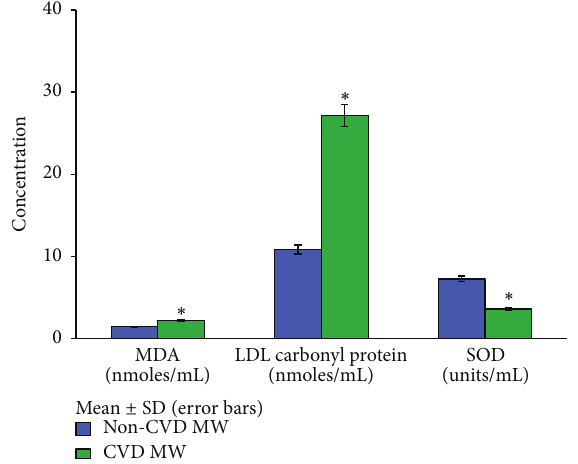
Figure 3: Levels of MDA, LDL carbonyl content, and SOD in normolipidemic CVD and non-CVD menopausal women. MDA, malondialdehyde; SOD, superoxide dismutase. ∗ 𝑝 < 0.05 significant difference observed in the levels of MDA, LDL carbonyl protein, and SOD between normolipidemic CVD and non-CVD menopausal women.